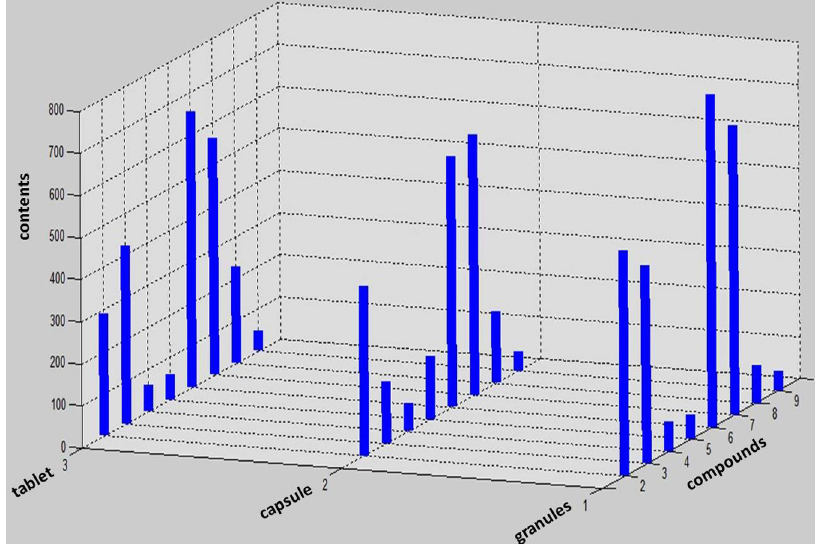
Figure 2. The average content of target markers except gallic acid in three dosage forms.